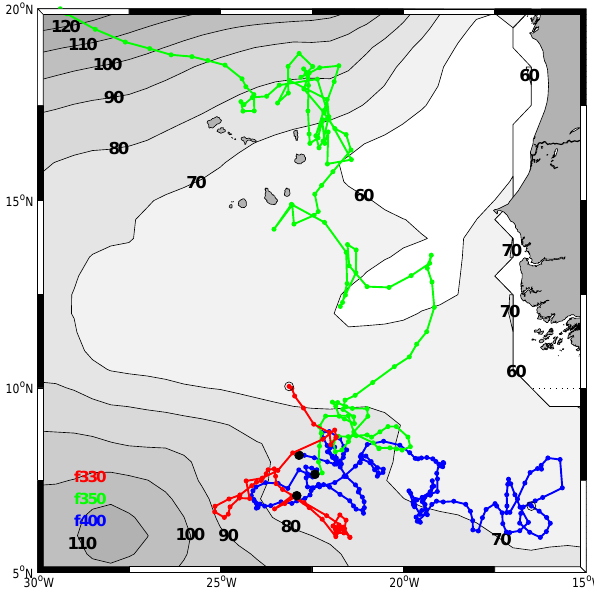
Figure 8. Annual mean climatological oxygen distribution (grey shaded contours, µmolkg − 1 ) at 350m depth from CARS 2009 cli- matology (Ridgway et al., 2002) with trajectories (in color) of three floats deployed in April 2008 (red 330m (f330), green 350m (f350), blue 400m (f400)). The first measurement cycle is shown as solid dot and the last cycle as open circle (Table